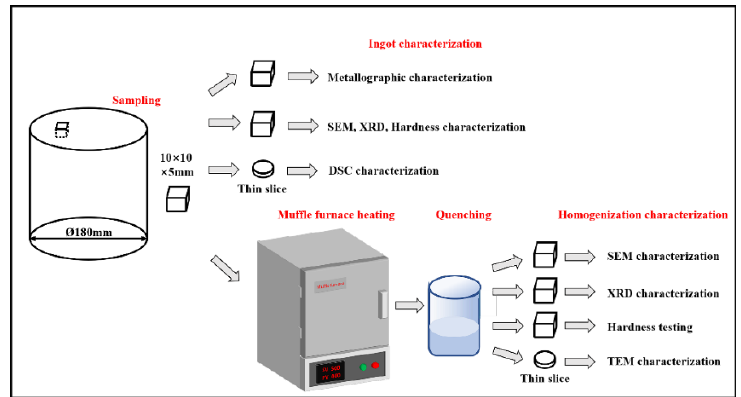
Figure 2. Schematic diagram of the workflow.